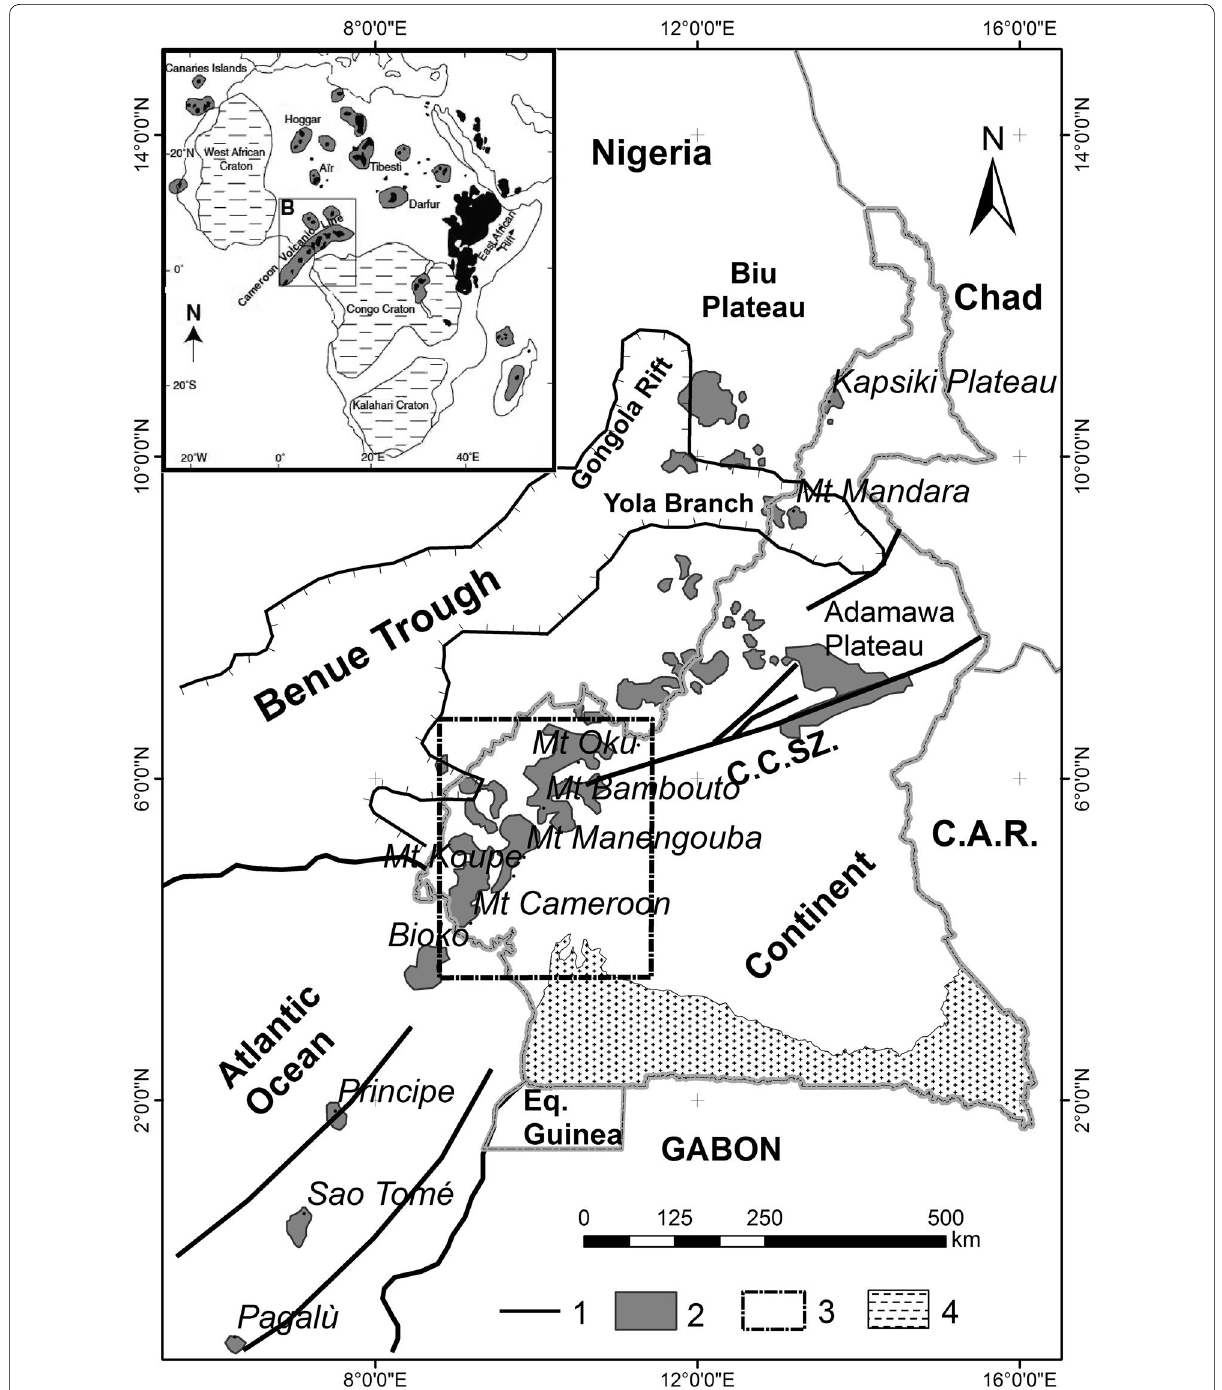
Fig. 1 Location of the Cameroon Volcanic Line. C.A.R. Central African Republic, Eq. Equatorial, CCSZ Central Cameroon shear zone, 1 fault, 2 Cam‑ eroon Volcanic Line, 3 Pan‑African fold belt, 4 Congo craton (modified from Lee et al. 1994; Ballentine et al. 1997; Ngako et al. 2006; Nkouathio et al.